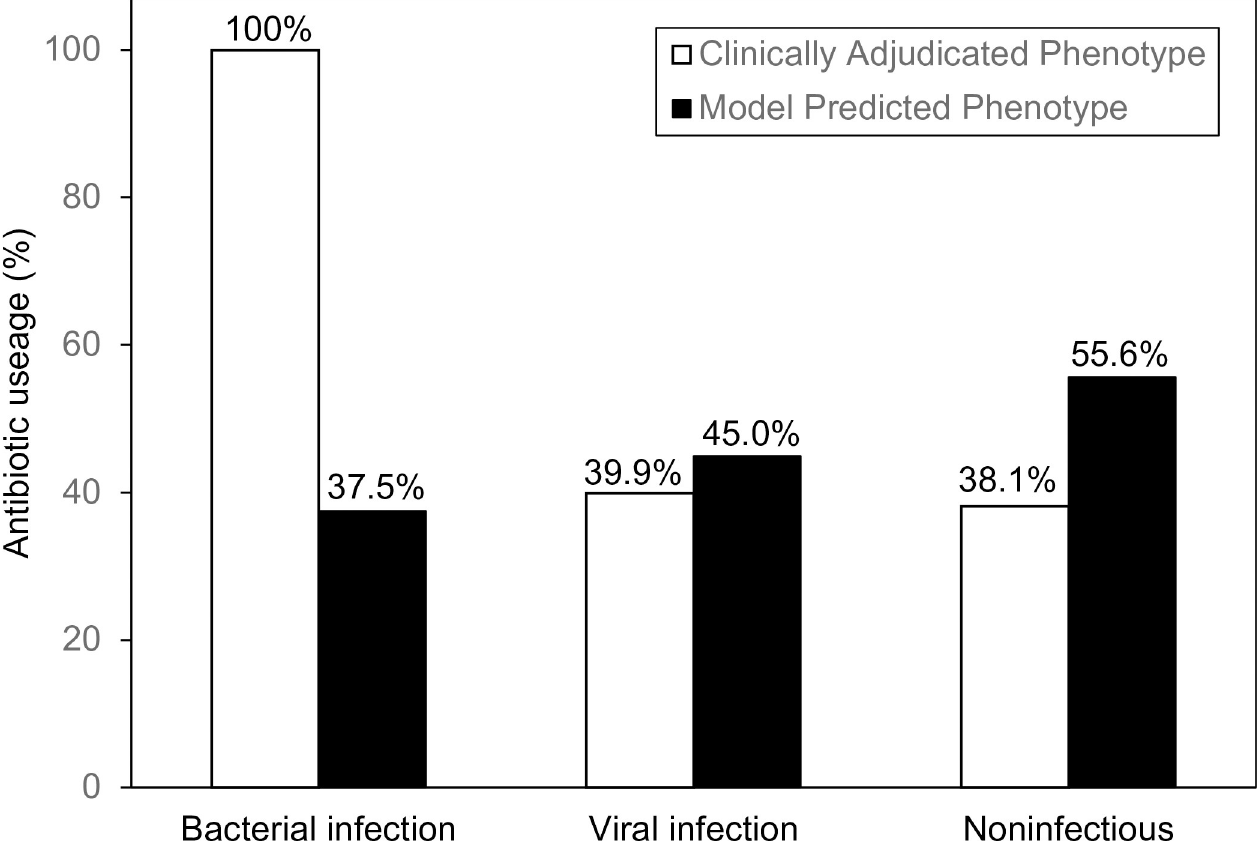
Fig 5. Frequency of antibiotic prescription in different infection classes. Antibiotic prescription during emergency room or hospital stay was recorded for each subject. Antibiotic prescription rate was calculated for the clinical adjudication groups and this was compared to the antibiotic prescription rate in the model-predicted groups. The respective percentages are indicated at the top of each bar. Antibiotics were prescribed more frequently for subjects with viral and noninfectious signatures than for subjects with bacterial signatures.